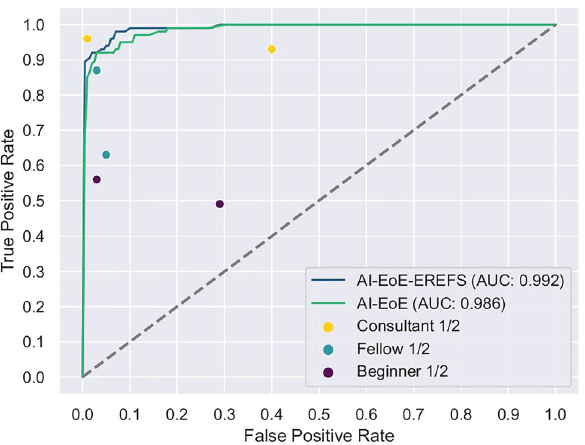
Figure 4. ROC curves and AUC values of AI-EoE and AI-EoE-EREFS on the external data set (ExD) compared with human endoscopists who had varying experience